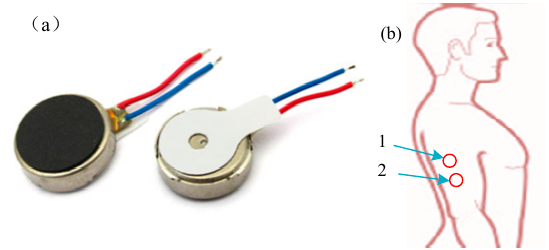
Figure 7. Vibrating motor ( a ) and vibration stimulation location ( b ).